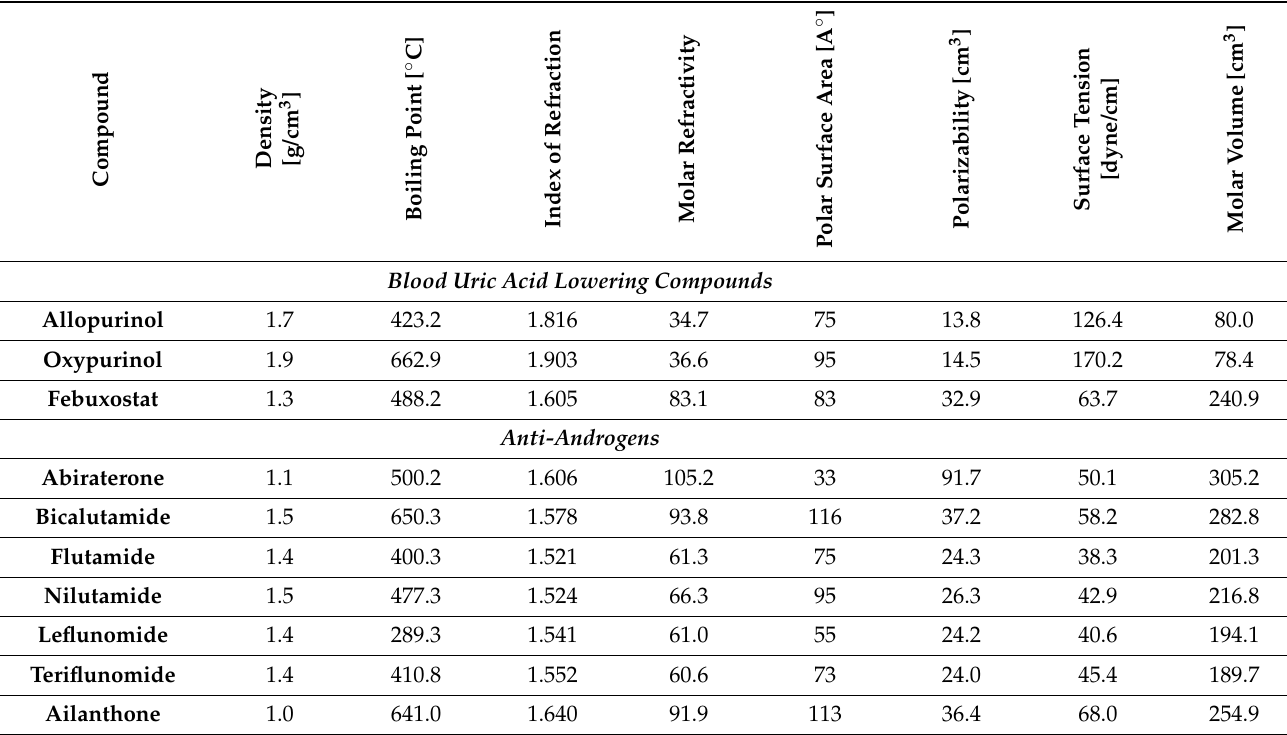
Table 2. Different physicochemical parameters of tested